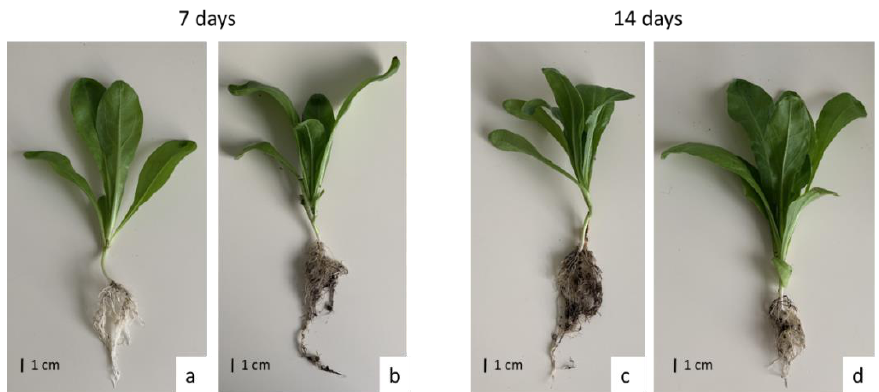
Figure 12. Control ( a , c ) and cadmium-treated ( b , d ) C. officinalis plants after 7 and 14 days of cultivation.